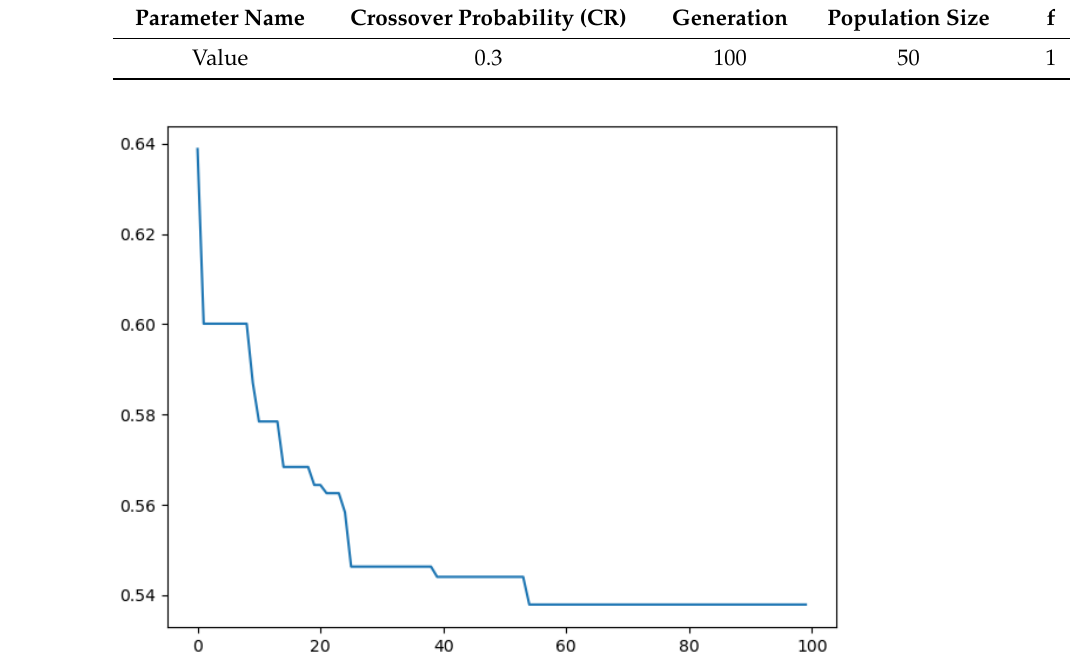
Table 13. Optimization results.